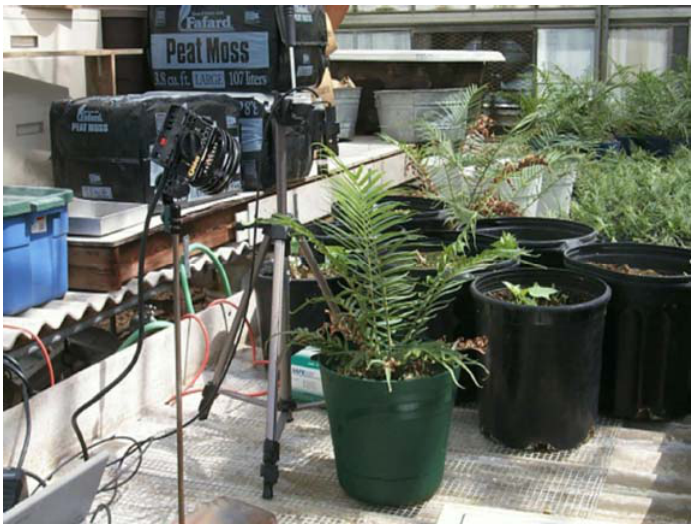
Figure 3. Spectral data collection in the